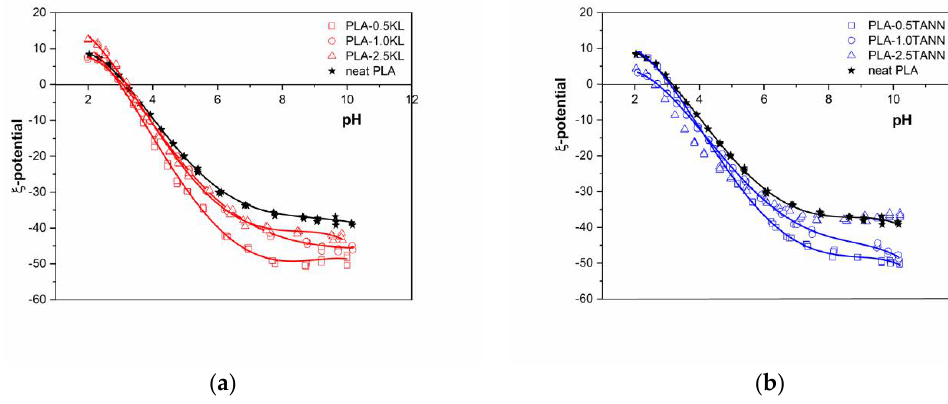
Figure 5. Zeta potential of ( a ) PLA-KL composites and ( b ) PLA-TANN composites in the range of pH 2–12. The total zeta potential of PLA-KL and PLA-TANN composites with high negative zeta potential at high pH towards more positive values was also determined in Figure 5.